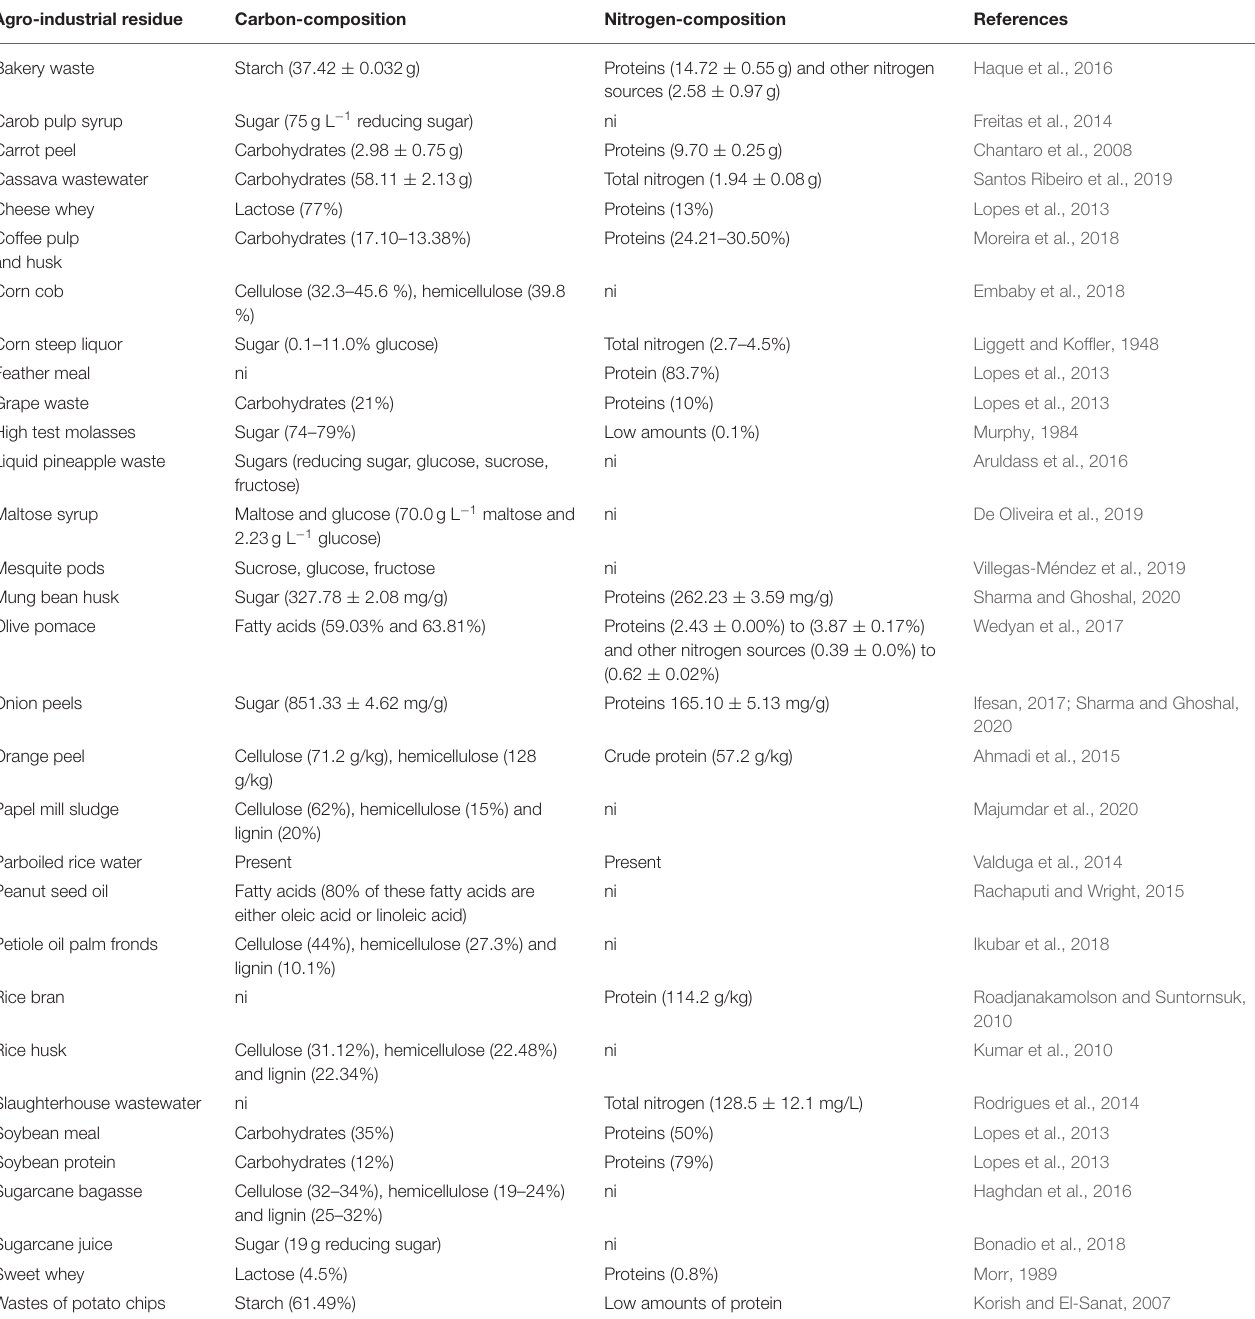
TABLE 3 | Average carbon and nitrogen composition of the agro-industrial